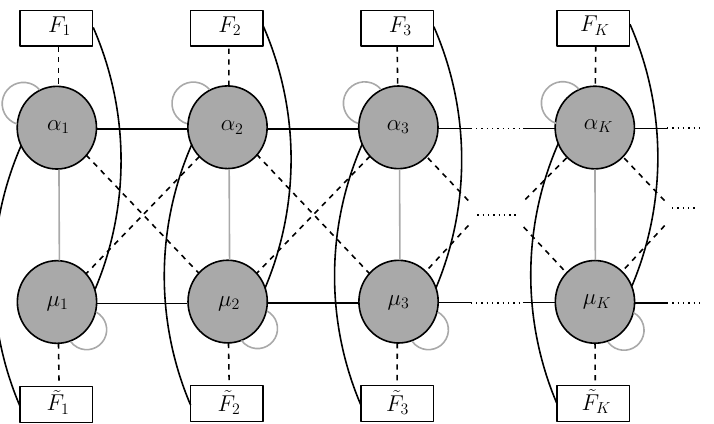
Figure 2. A generic quiver field theory in which the IR is dual to the holographic background defined by the functions in (6) and